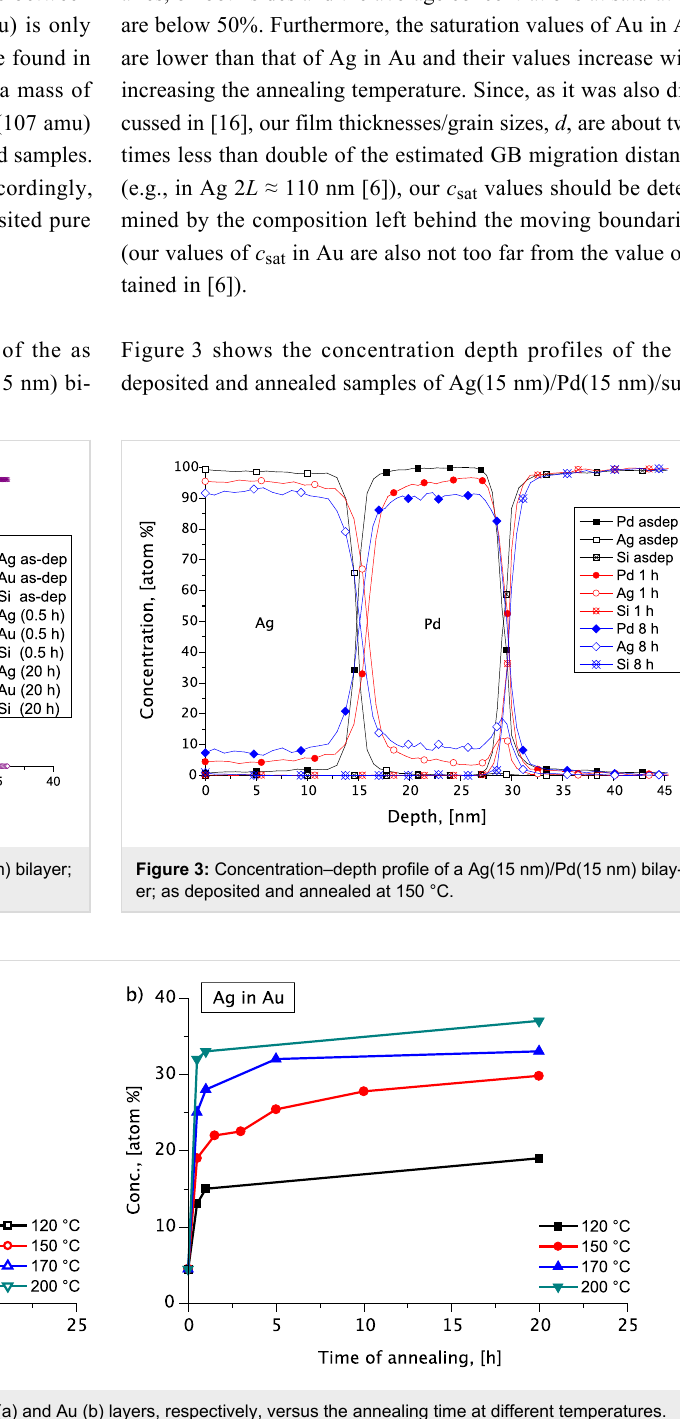
Figure 2: Average concentration of Au and Ag inside the Ag (a) and Au (b) layers, respectively, versus the annealing time at different temperatures.